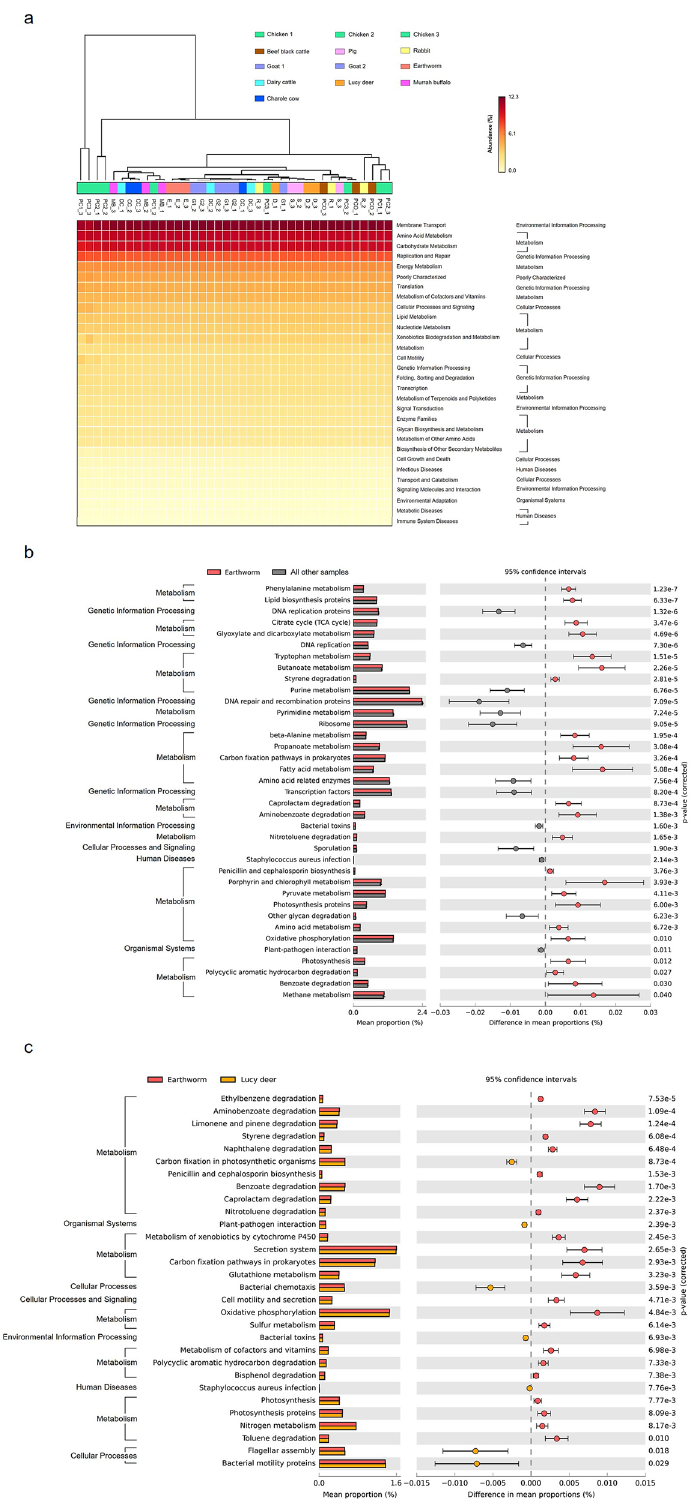
Figure 6. Predictions of functional profiles into KEGG levels 2 and 3 from quantitative microbiota using PICRUSt and STAMP. ( a ) On the top showing the clustering of functional profiles of manure samples by UPGMA. The significantly different KEGG functions between ( b ) the earthworm and the average from the other samples, and ( c ) the earthworm and Lucy deer, were compared using two-sided Welch’s t -test (corrected p <